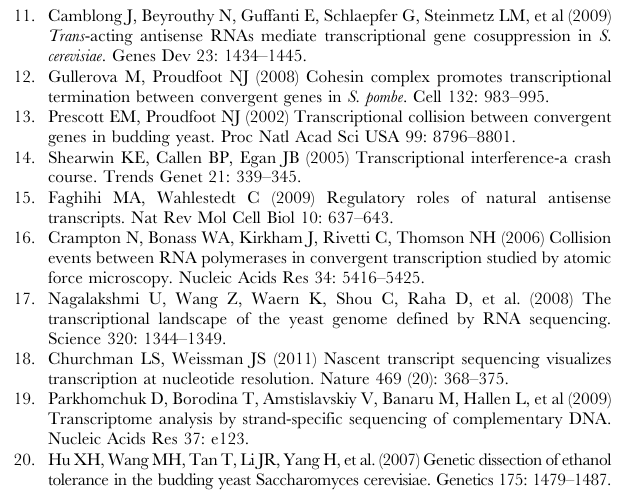
Figure S2 Correlation in expression between convergent gene pairs with overlapping 3 9 - UTRs across seven growth environments.